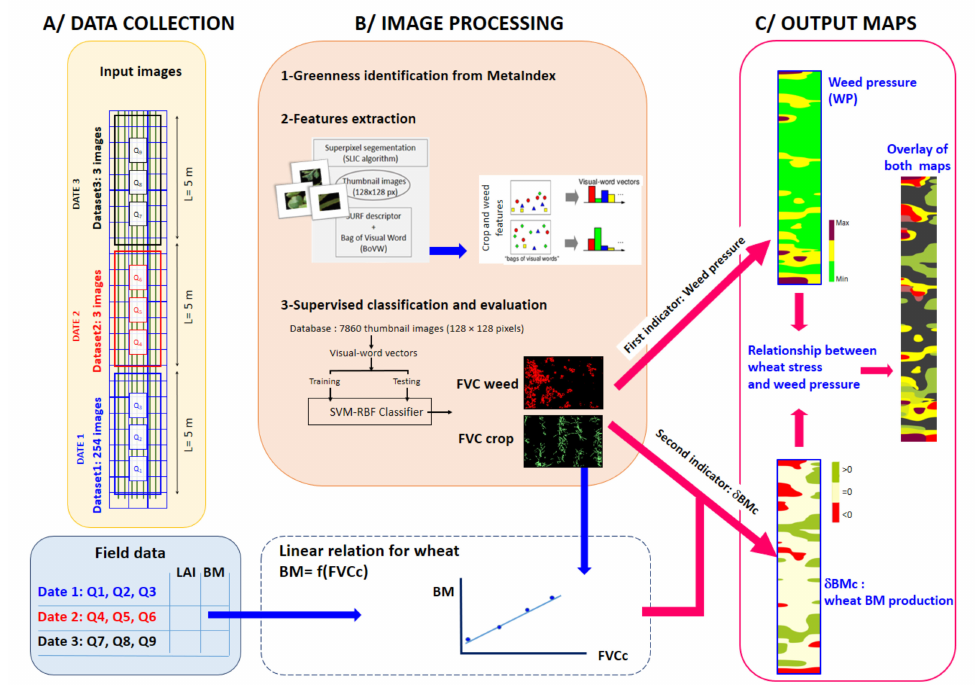
Figure 2. Methodological framework with the three main steps: data acquisition ( A ), image processing and classification results ( B ), and output maps (FVC: fractional vegetation cover, WP: weed pressure and δ BMc: wheat above-ground biomass production) to monitoring the impact of weed on wheat growth ( C